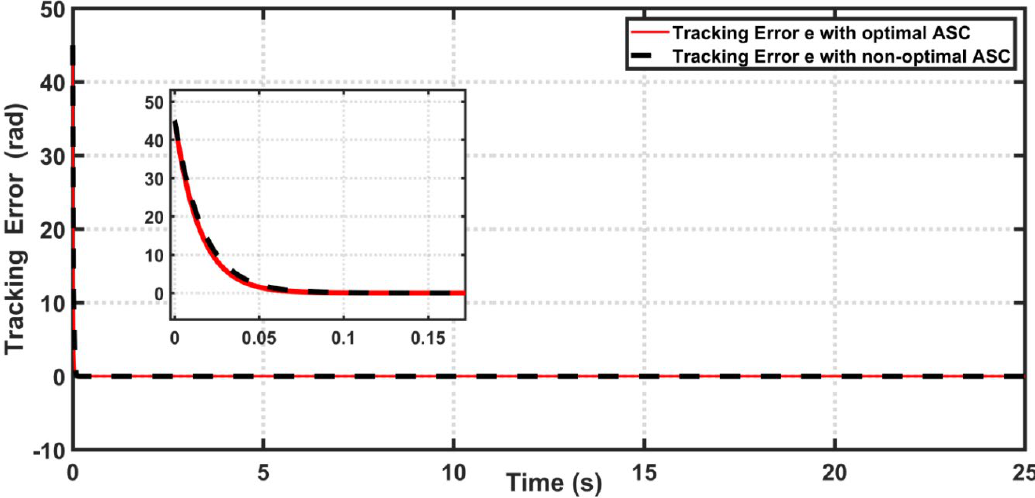
Figure 8. The behaviours of knee angular positions based on non-optimal and optimal ASC.